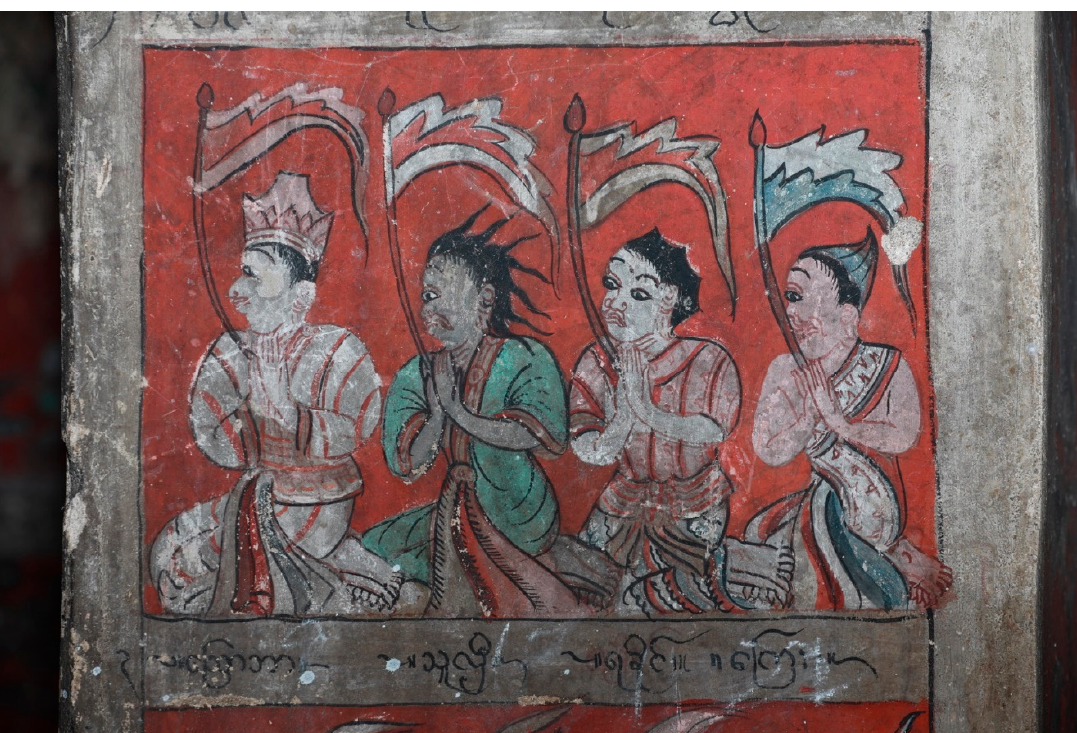
Figure 46. Shin Bin Pwin Lan, 19th century. Four Representatives of Groups among the 101 Tribes, including Rakhine.